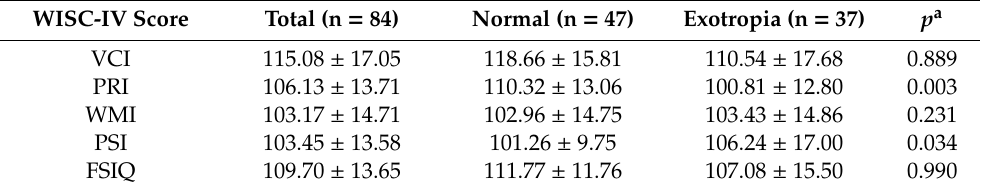
Table 2. Comparison of WISC-IV scores between the exotropia group and the normal group. WISC-IV Score